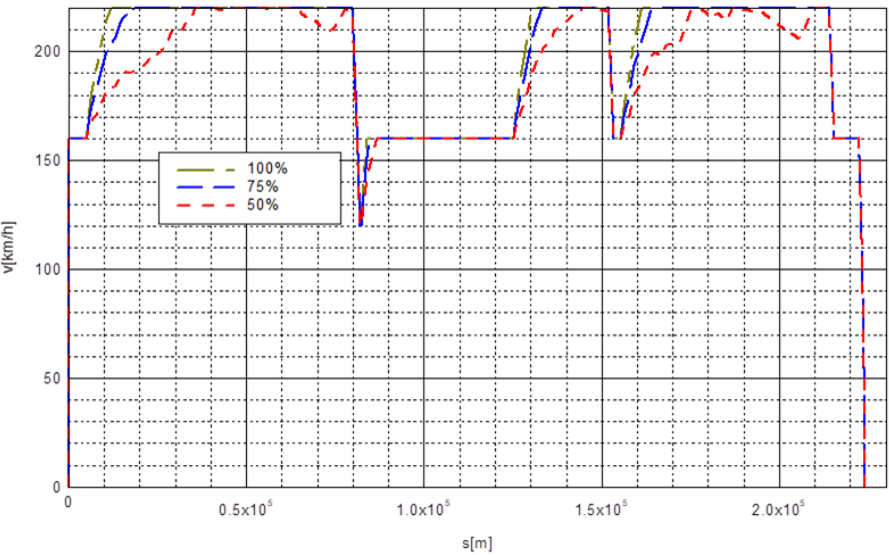
Figure 5. Influence of available power (100%, 75%, and 50%) on speed changes of ETR 610 (ED250) train on route Grodzisk Maz. – Zawiercie with set speed limit sections. Source: Own study — Results of simulations.